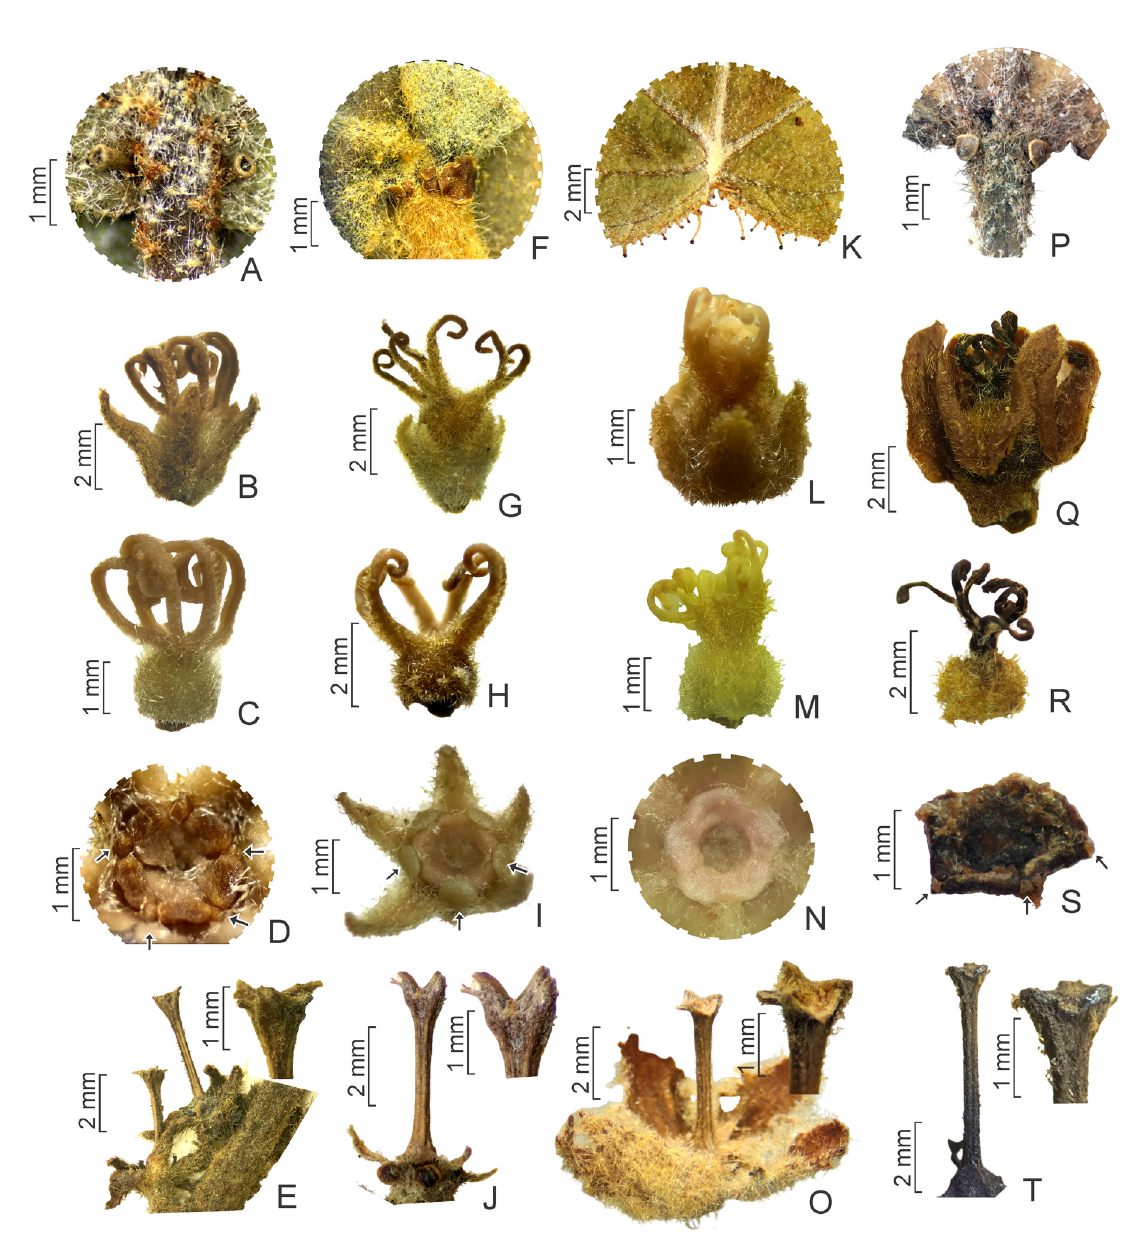
Fig. 4. Morphological comparison of C. restingae Sodré & Riina sp. nov. and related species. A–E . Croton echioides Baill. A . Basilaminar nectaries. B . Pistillate flower. C . Gynoecium. D . Nectary disk and glandular petals (arrows) of pistillate flower. E . Carpophore showing the columella, detail of the apical appendages. – F – J . C. gracilipes Baill. F . Basilaminar nectaries. G . Pistillate flower. H . Gynoecium. I . Nectary disk and glandular petals (arrows) of pistillate flower. J . Carpophore showing the columella, detail of the apical appendages. – K–O . C. laceratoglandulosus Caruzo & Cordeiro. K . Basilaminar colleters. L . Pistillate flower. M . Gynoecium. N . Nectary disk of pistillate flower. O . Carpophore showing the columella, detail of the apical appendages. – P–T . C. restingae sp. nov. P . Basilaminar nectaries. Q . Pistillate flower. R . Gynoecium. S . Nectary disk and glandular petals (arrows) of pistillate flower. T . Carpophore showing the columella, detail of the apical appendages. Photos: A–E from R.C. Sodré 3314 ; F–J from R.C. Sodré 3413 ; K–O from R.C. Sodré 3461 ; P–S from M.F. Vasconcelos s.n. ; T from A. Souza et al. 3163